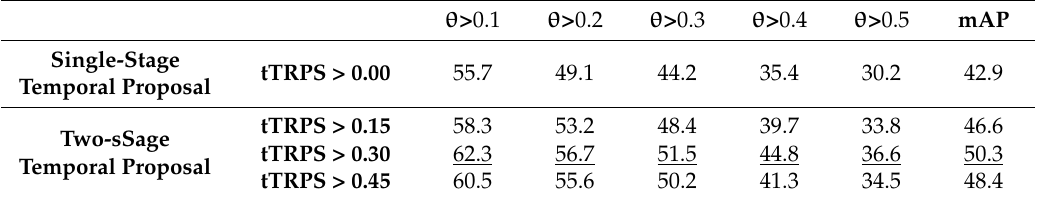
Table 4. Spatio-temporal action-detection performance (video-mAP) depending on the increasing threshold of temporal region proposal scores (tTRPS) in the UCF-101